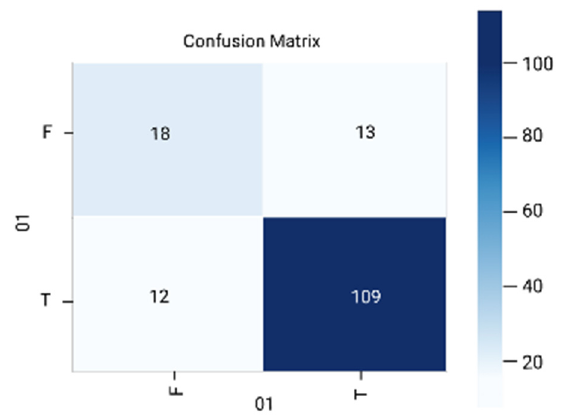
Figure 8. Naïve Bayes.